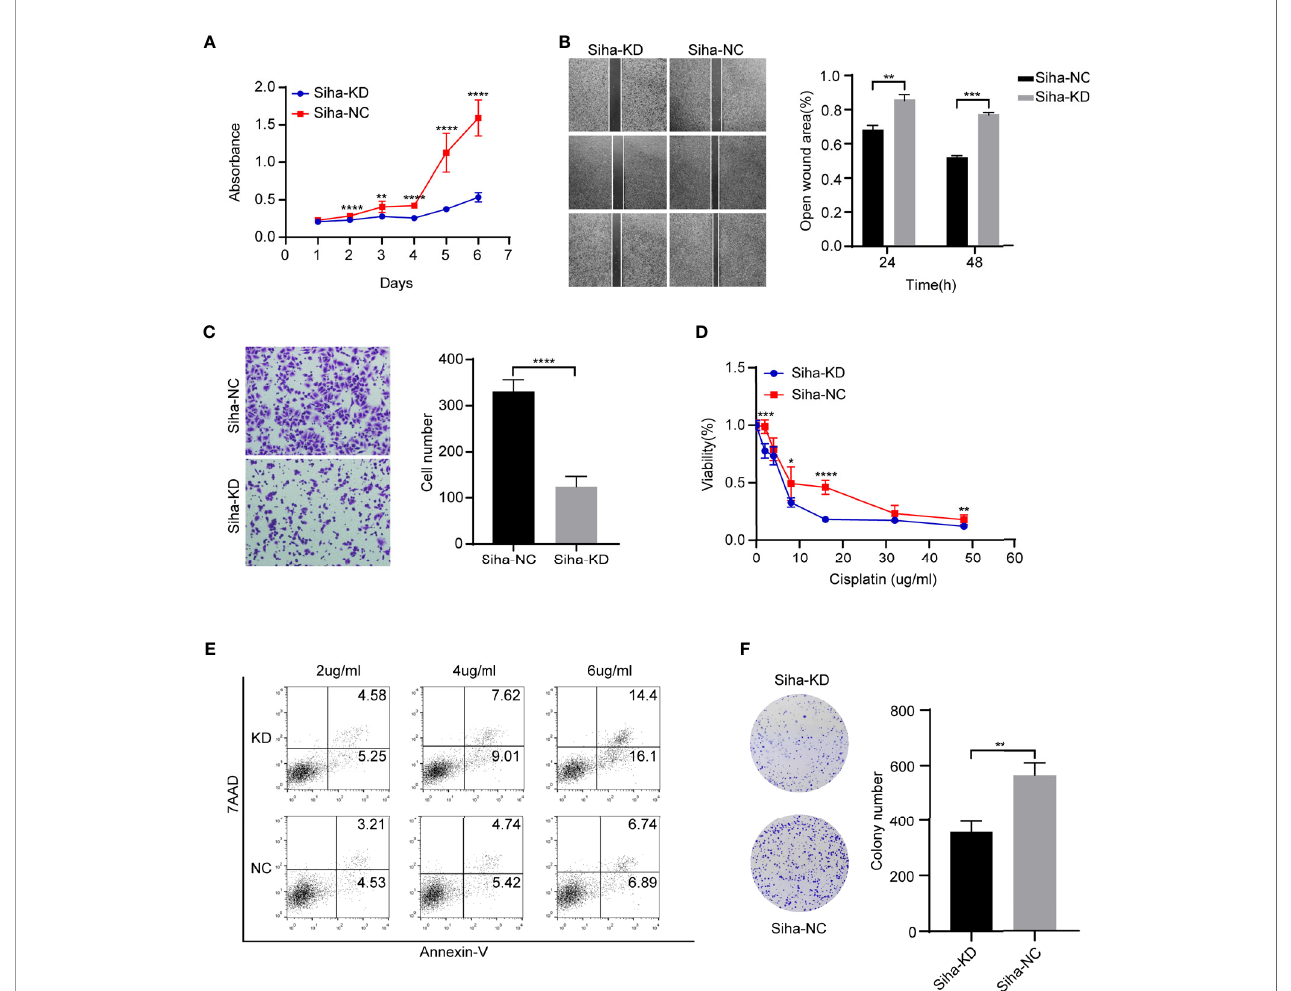
FIGURE 6 | Effects of ADGR1 expression on cell proliferation, migration, invasion, and sensitivity to cisplatin. (A) Siha-KD exhibited decreased proliferation by CCK8 assay (**P < 0.01, ****P < 0.0001). (B, C) Downregulation of ADGRG1 inhibited cell migration and invasion by wound healing and transwell assays (**P < 0.01, ***P < 0.001, ****P < 0.0001). (D) Cell viability of Siha-KD was lower than Siha-NC when exposed to cisplatin (*P < 0.05, ***P < 0.001, ****P < 0.0001). (E) Knockdown of ADGRG1 enhanced cell apoptosis in cisplatin. (F) Siha-KD formed fewer colonies than Siha-NC in 2 m g/ml concentration of cisplatin. (**P <